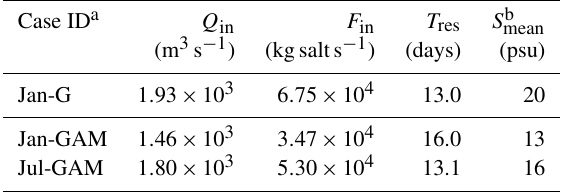
Table 2. Total exchange flow ( Q in ) and the resulting salt flux ( F in ) at the Galveston Bay mouth, as well as the mean residence time of the bay ( T res ) based on the isohaline method in MacCready